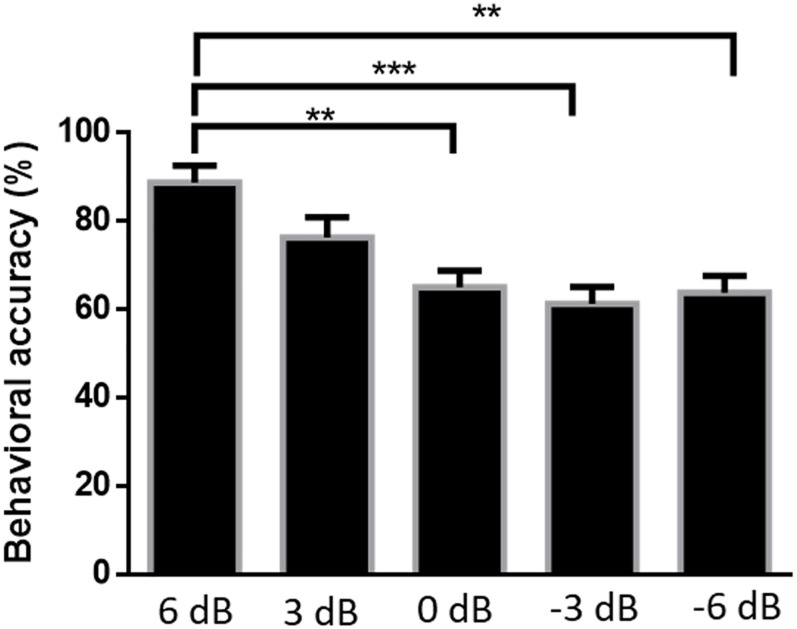
Average percentages of correct responses to questions related to the content of attended speech at each signal-to-noise ratio. Error bars display mean ± standard deviation **P < 0.01, ***P < 0.001 (prediction differences).